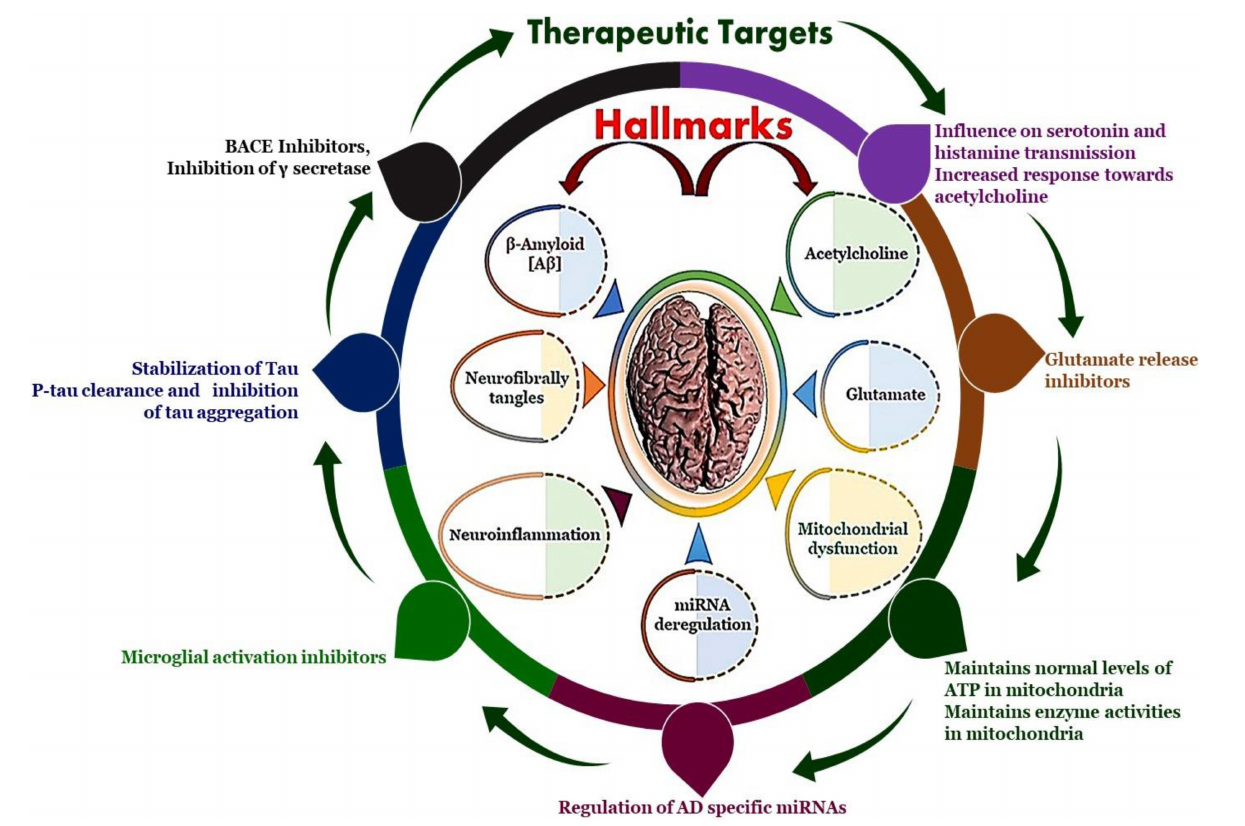
FIGURE 2 | The neuropathological hallmarks of Alzheimer’s disease: formation of amyloid-beta plaques, formation of neurofibrillary tangles, miRNA deregulation, mitochondrial dysfunction, neuroinflammation and therapeutic targets such as BACE inhibitors and Inhibition of γ secretase, stabilization of Tau protein, influence on serotonin and histamine transmission, maintains normal levels of ATP in mitochondria and maintains enzyme activities in mitochondria, microglial activation inhibitors and regulation of specific miRNAs.